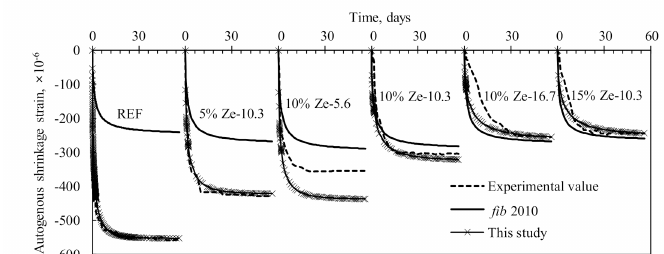
Figure 14. Comparisons between experimental and predicted autogenous shrinkage strains using the fib 2010 model and proposed